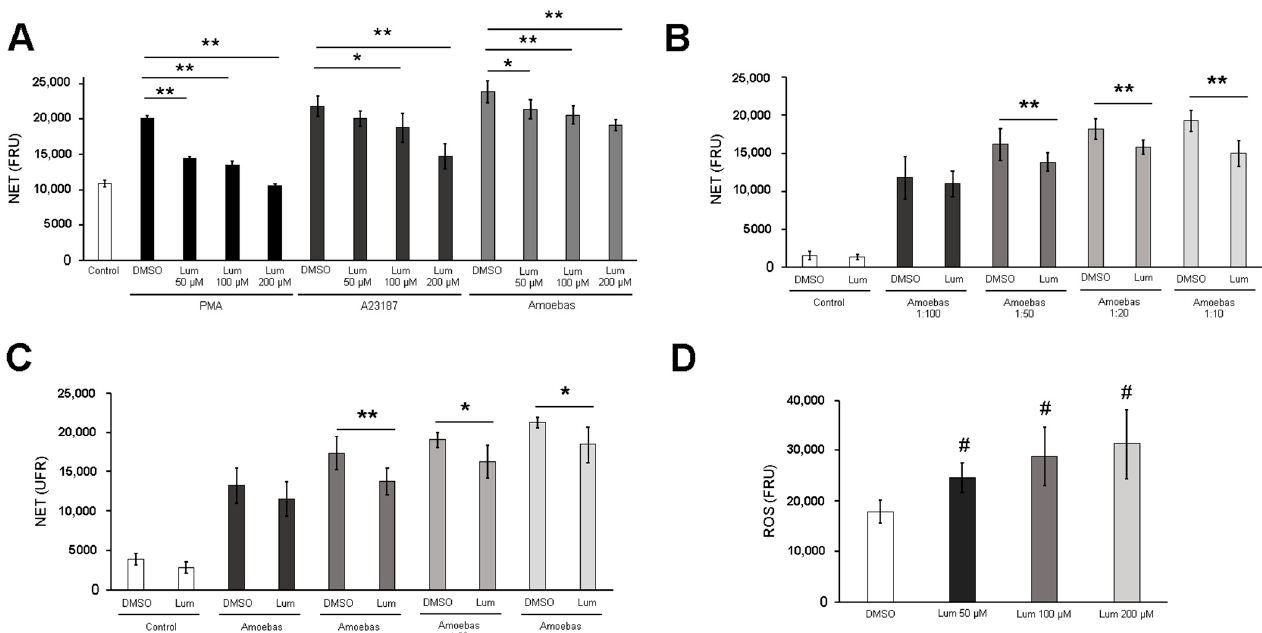
Figure 7. MPO activity is required for NETosis induced by E. histolytica trophozoites. ( A ) Neutrophils (1 × 10 5 ) were culture in RPMI-1640 medium supplemented with 5% FBS, 500 nM SYTOX ® Green and luminol (Lum, 50, 100 or 200 µM or DMSO). Cells were stimulated with PMA (50 nM), A23187 (10µM) or 5 × 10 3 luminol-pretreated trophozoites (according with concentration present in the medium). Fluorescence was read after 4 h. ( B ) Neutrophils (1 × 10 5 ) were pretreated with 50, 100 and 200 µM luminol or DMSO during 30 min. Posteriorly, cells were transferred to RPMI-1640 medium added with 5% FBS and 500 nM SYTOX ® Green and then stimulated with PMA (50 nM), A23187 (10 µM) or E. histolytica trophozoites at ratios of 1:100, 1:50, 1:20 and 1:10. Fluorescence was read at 4 h. ( C ) Neutrophils (1 × 10 5 ) were cultured in RPMI-1640 medium supplemented with 5% FBS, 500 nM SYTOX ® Green and luminol (200 µM or DMSO). Cells were stimulated with trophozoites pretreated with luminol (200 µM or the vehicle DMSO) at ratios 1:100, 1:50, 1:20 or 1:10. Fluorescence was read at 4 h. ( D ) Amoebic trophozoites were treated with DMSO or luminol at 50, 100 and 200 µM for 30 min and then H 2 DCFDA (100 µM) was added. Cells were incubated for another hour and after treatment, trophozoites were resuspended in RPMI-1640 medium supplemented with 5% FBS. A total of 1 × 10 5 trophozoites were placed and fluorescence was read. For ( A – D ) the NET or ROS amount are expressed in fluorescence relative units (FRU). Values are means ± SD of three independent experiments. * p < 0.01, ** p < 0.001, # p < 0.0001 with respect to the control.